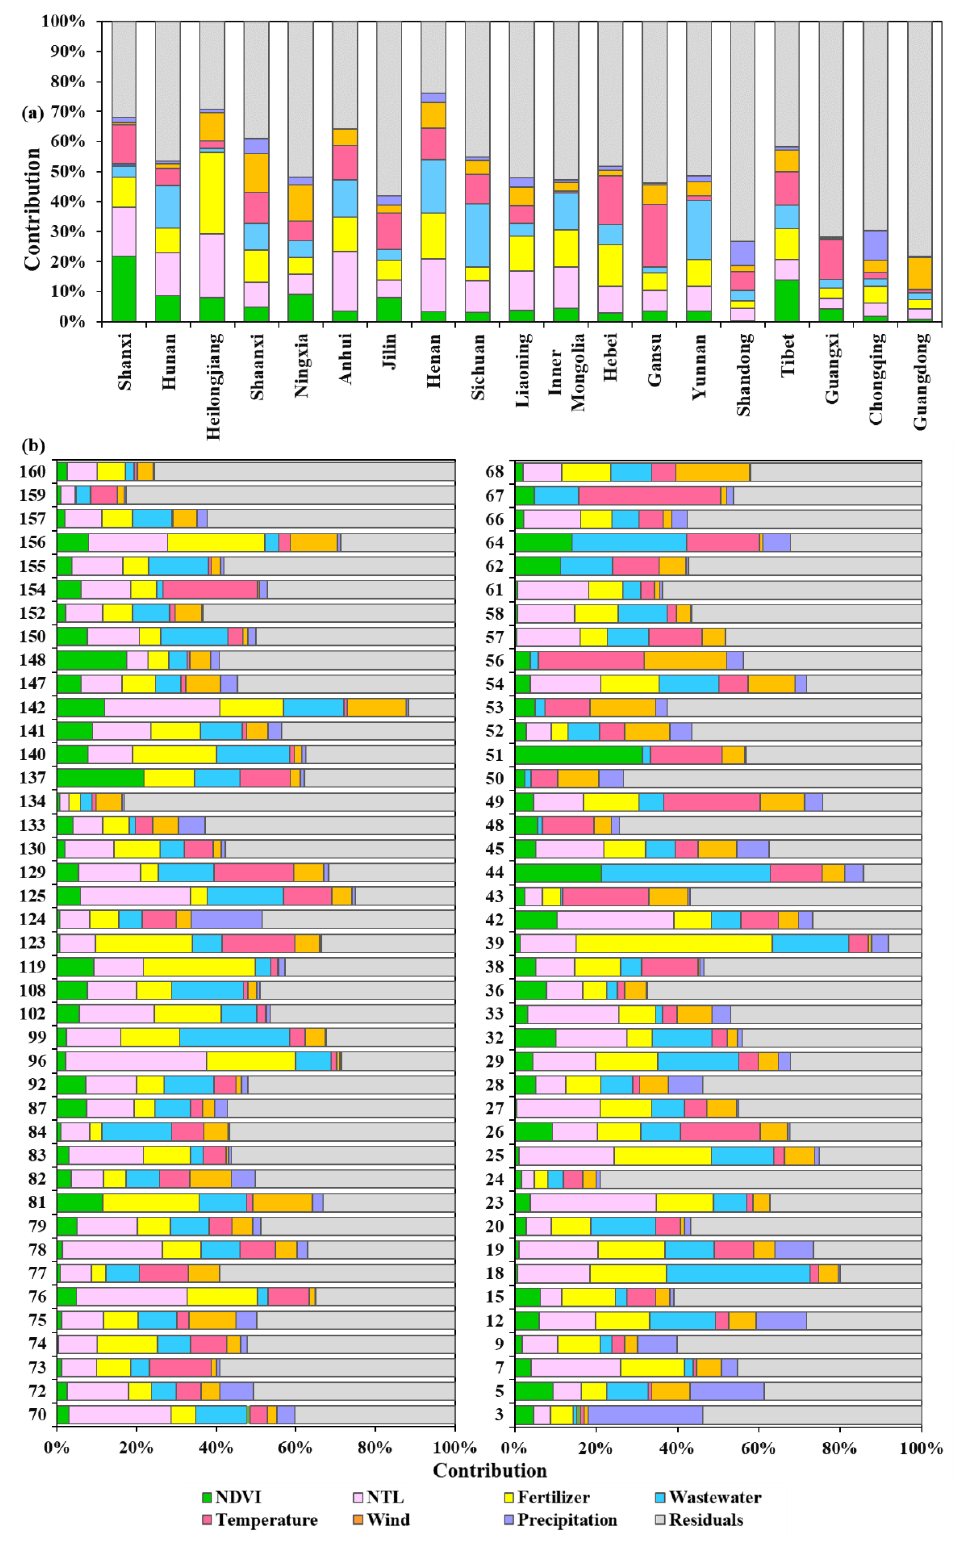
Figure 5. The relative contributions (in percentage) of the seven examined factors driving the interannual changes in mean SDD during 1984 – 2018 in the nineteen provinces ( a ) and eight-two watersheds ( b ) that had shown significant ( p < 0.05) trends in mean SDD. General boundaries of these provinces and watersheds are depicted in Figure S2.